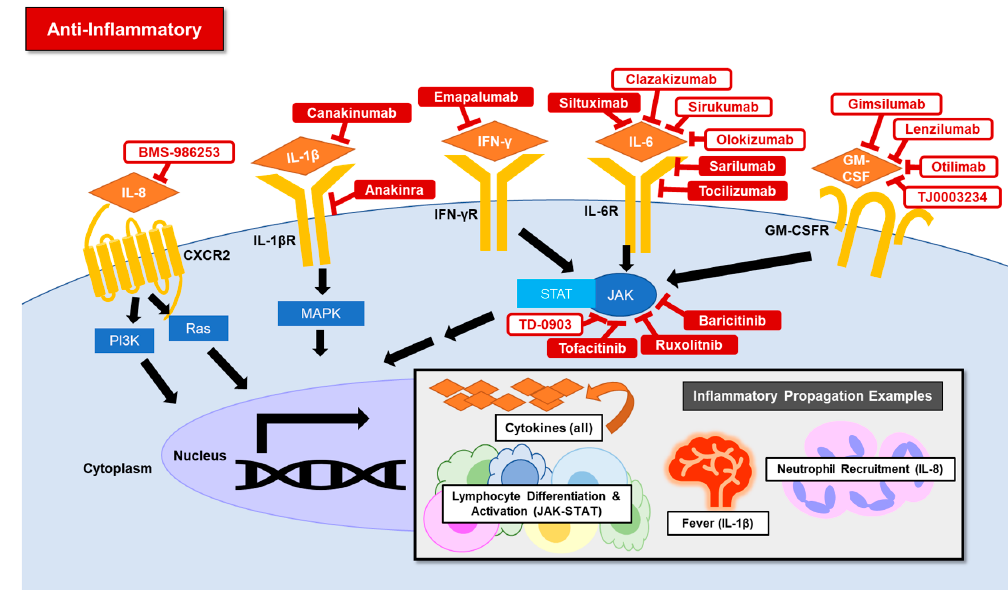
Figure 3. Schematic represents potential mechanisms of anti ‐ inflammatory therapies under Figure3. Schematicrepresentspotentialmechanismsofanti-inflammatorytherapiesunderinvestigation investigation to treat COVID ‐ 19 related inflammation. Solid red drug names are FDA ‐ approved, and to treat COVID-19 related inflammation. Solid red drug names are FDA-approved, and red outlined red outlined drug names are investigational. drug names are